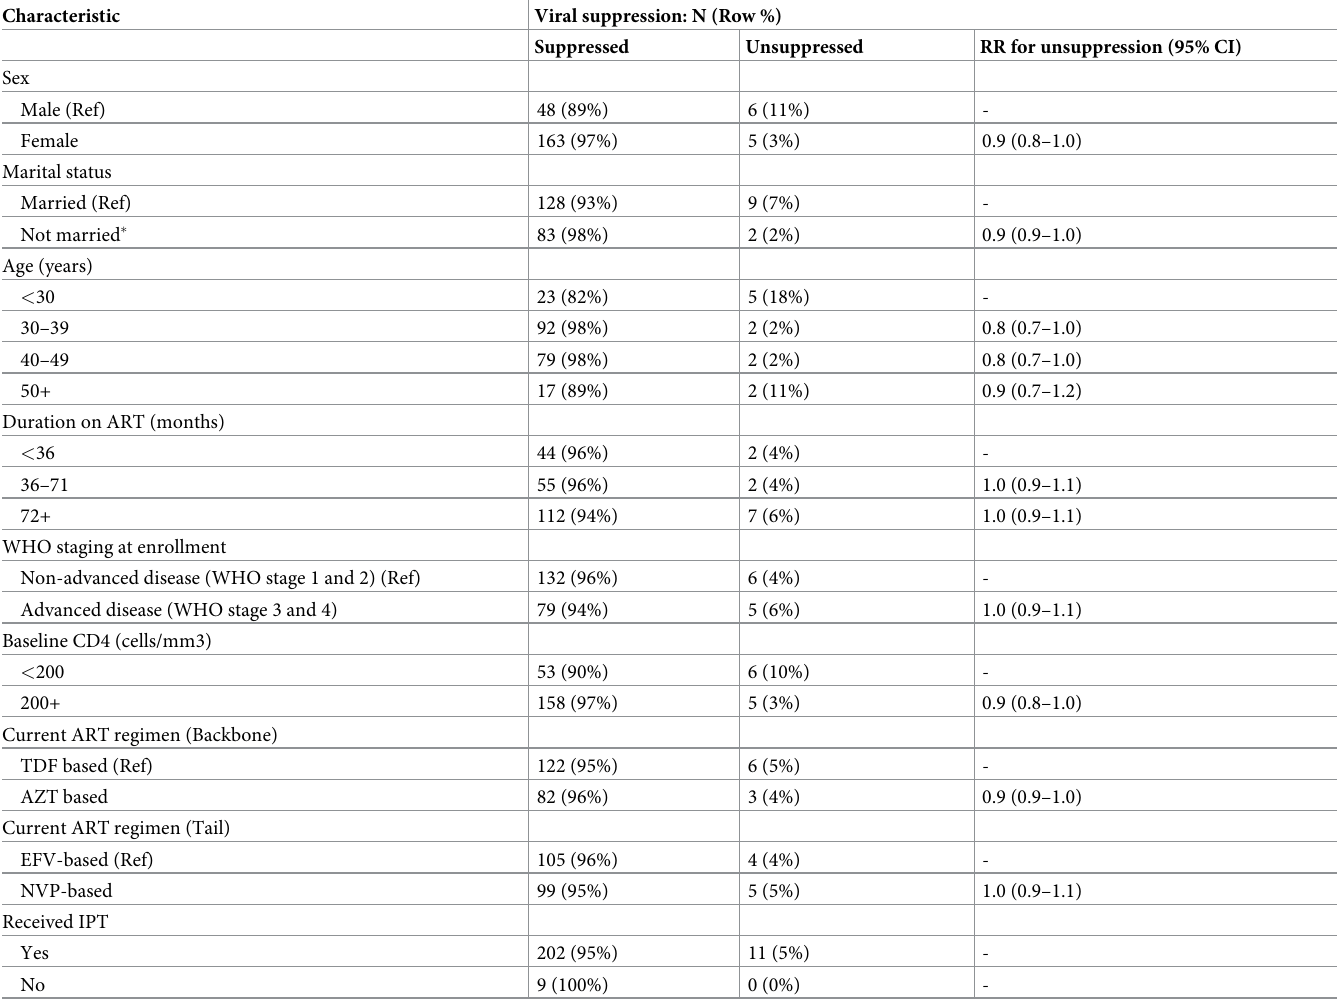
Table 3. Univariate correlates of viral suppression among 222 HIV-positive PEs in 140 sites in Kenya.